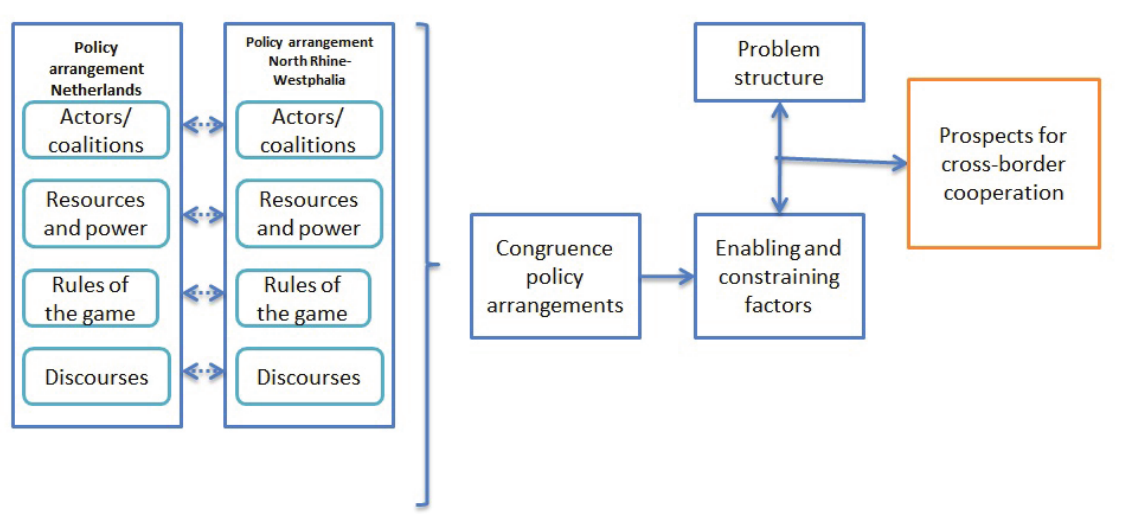
Figure 2 Prospects for cross-border cooperation, a conceptual